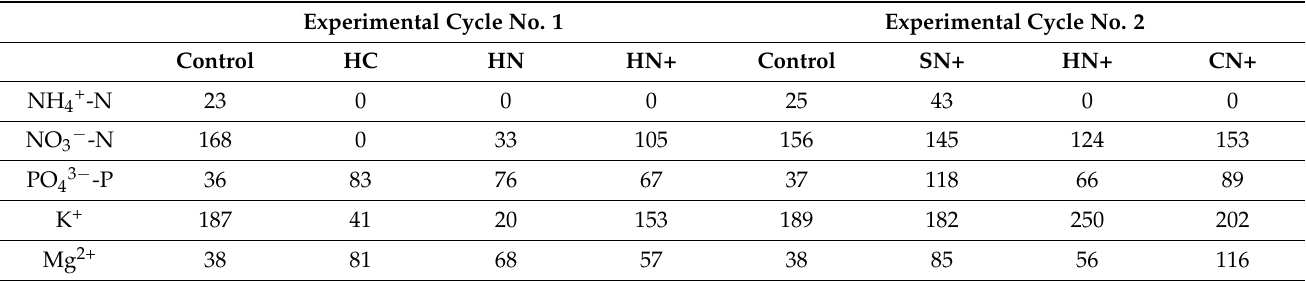
Table 4. NPK content (mg/L) in the nutrient solutions used in the hydroponic culture of lettuces. Experimental Cycle No.